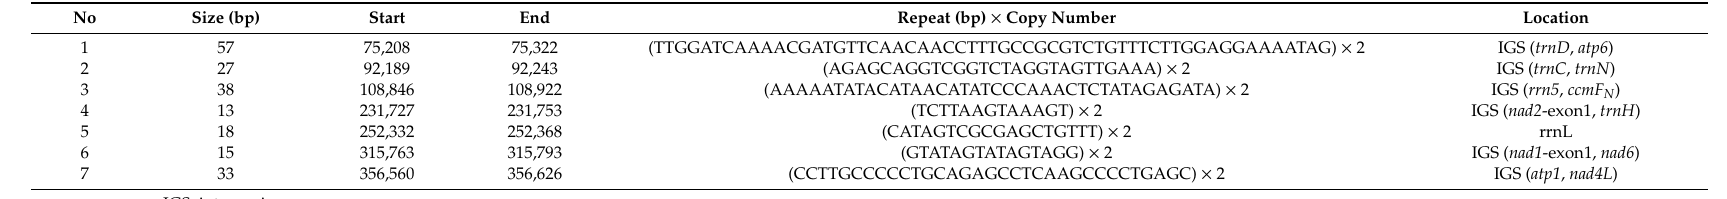
Table 5. Distribution of tandem repeats in P. vulgaris